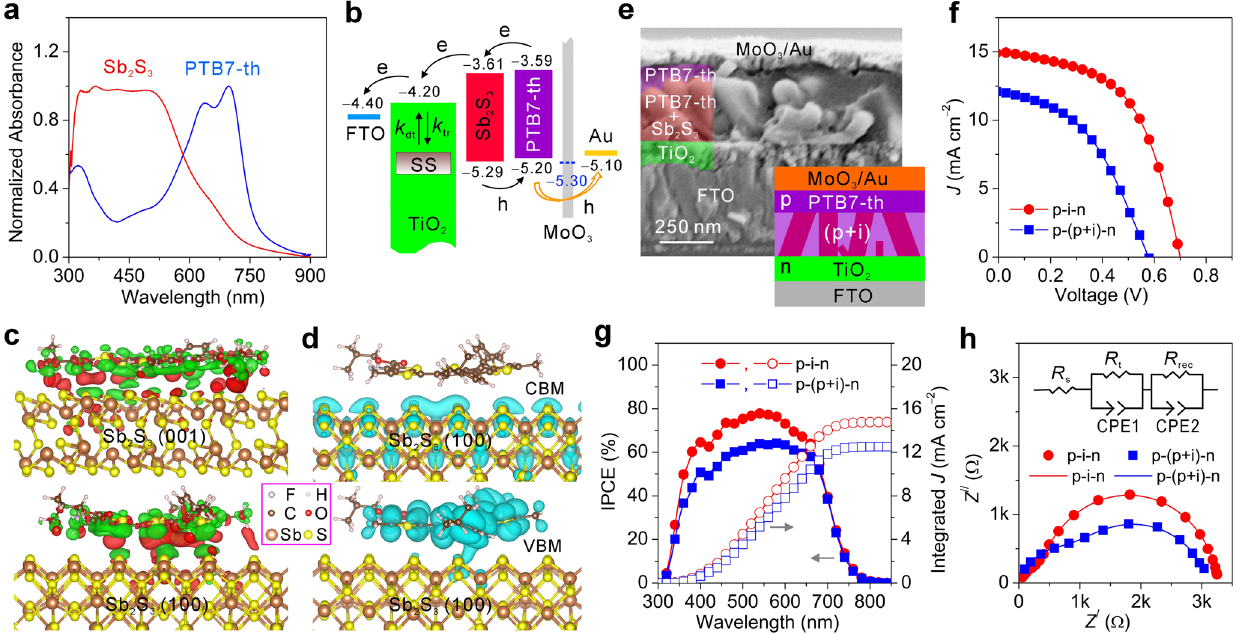
Fig. 4 Material property and architecture-dependent device performance. a Absorption spectra of Sb 2 S 3 /TiO 2 -nanoarray heterojunction (Sb 2 S 3 /TiO 2 - NHJ) and PTB7-th fi lm. b Energy level diagram and charge transfers amongst the materials in the solar cells of this work, where the photogenerated electrons injected into the conduction band of TiO 2 may be trapped ( k tr ) by surface states (SS) and the trapped electrons can be thermally released ( k dt ) into the conduction band for transport. c Density functional theory (DFT) calculated interfacial interaction at the Sb 2 S 3 /PTB7-th interfaces formed by PTB7-th on Sb 2 S 3 (001) plane (above) and Sb 2 S 3 (100) plan (below), where red color denotes charge accumulation and green color stands for charge depletion, and the electron density isosurface is set to 0.0004 e Å − 3 . d DFT calculated wavefunctions of electronic states near the conduction band minimum (CBM) (above) and valence band maximum (VBM) (below) of Sb 2 S 3 (100)/PTB7-th interface system, where the isosurface of wavefunction square is set to 4 × 10 − 11 e Å − 3 . e Structure of p-(p + i)-n solar cell (up-left: cross-sectional scanning electron microscopy image of a practical